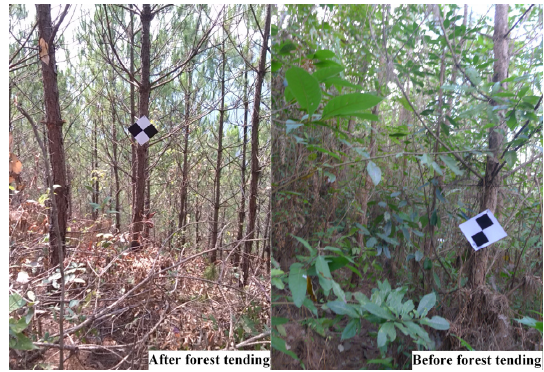
Figure 2. Photographs taken before (December 2013) and after (March 2014) forest